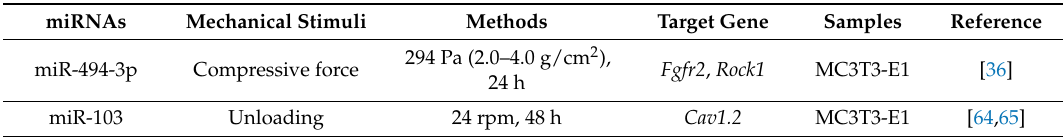
Table 4. Mechanosensitive miRNAs inhibit osteoblast